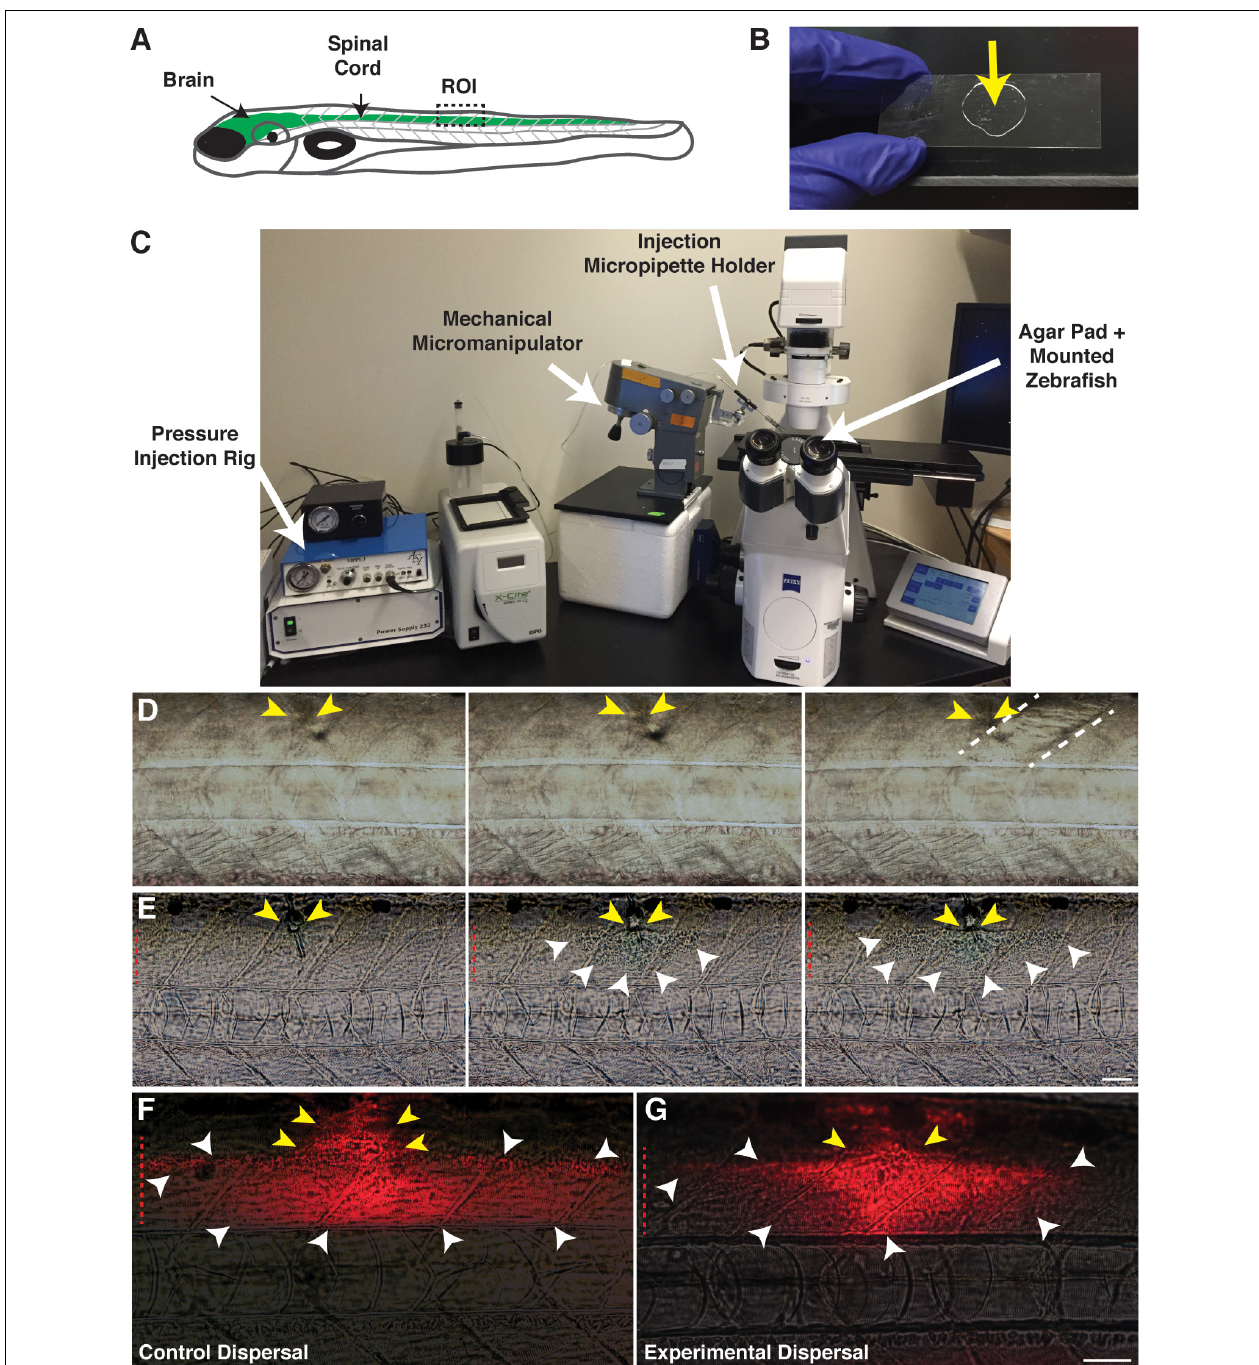
FIGURE 1 | Focal delivery of solutions into the zebrafish spinal cord. (A) Cartoon of a zebrafish larvae identifying the brain and spinal cord (green). The boxed region identifies the injection site/targeted region of interest (ROI). (B) An agar pad (arrow) solidified on a borosilicate glass coverslip is used as a mounting platform for larvae to perform spinal cord injections. (C) An agar pad containing mounted larvae is placed on a microscope stage, equipped with a pressure injection rig and mechanical micromanipulator to hold the injection micropipette. (D) Muscle injections are identified by a wavy appearance following dispersal of the injection solution. Yellow arrows identify the injection site. Dotted lines denote the muscle segment injected. (E) Solutions remain localized within the spinal cord following a successful spinal cord injection. Yellow arrows identify the injection site in the dorsal spinal cord. White arrowheads identify the solution dispersal region. (F) Dispersal region of a control solution containing water and the fluorescent tracer, Dextran-647. Yellow arrows identify the injection site. White arrowheads identify the dispersal region. (G) Dispersal region of a lysolecithin solution including the fluorescent tracer Dextran-647. Yellow arrows identify the injection site. White arrowheads identify the dispersal region. Red dashed lines denote the spinal cord. Scale bar, 50 µ